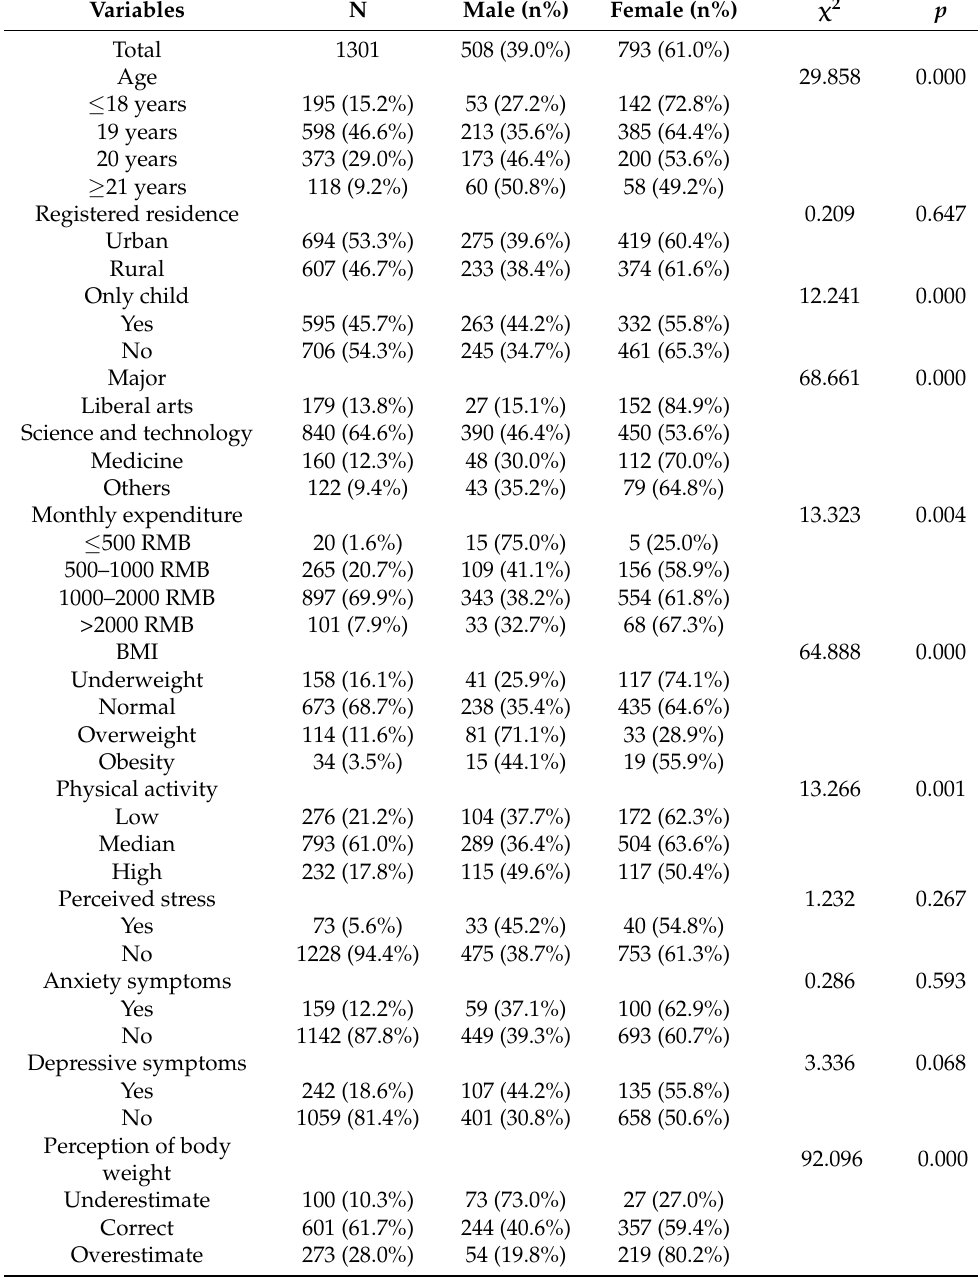
Table 1. General characteristics of the